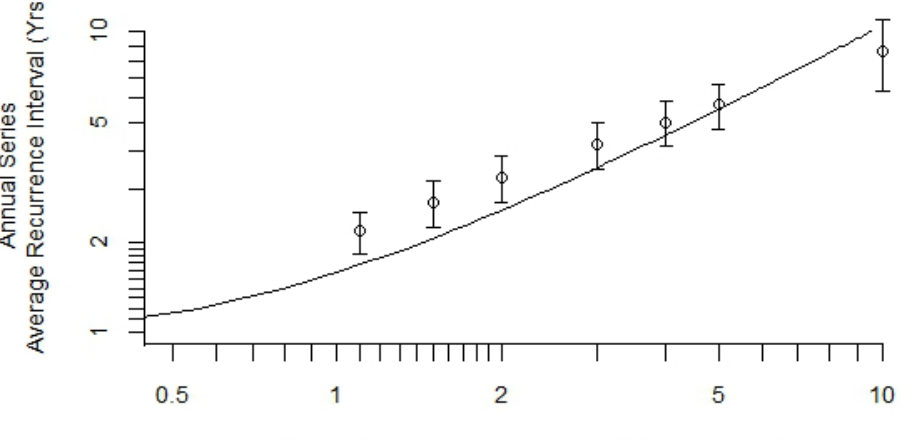
Figure 3. Comparison of annual and partial series average recurrence intervals ( T ). Conversion of annual series to partial series according to Langbein’s function is represented by the solid line, while points represent mean (plus and minus standard deviation) of 13 North-Eastern Tasmanian stream-flow